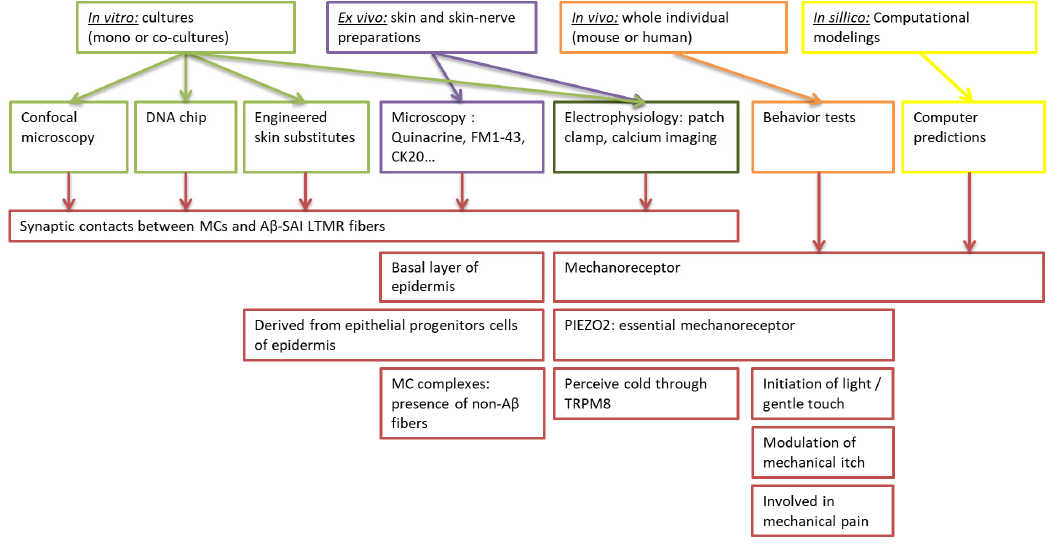
Figure 1. Representative diagram of the different approaches allowing the study of cells that compose the Merkel complexes. The different study methods are in vitro , ex vivo , in vivo , and in silico . In each approach, the material and the techniques are different. They complement each other to identify new functions or characteristics attributed to Merkel complexes.